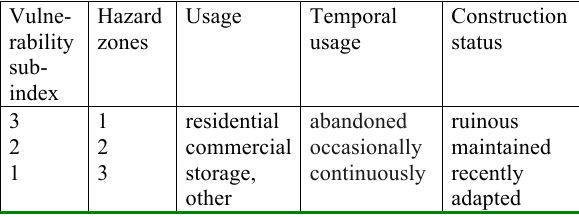
Table 6. Vulnerability